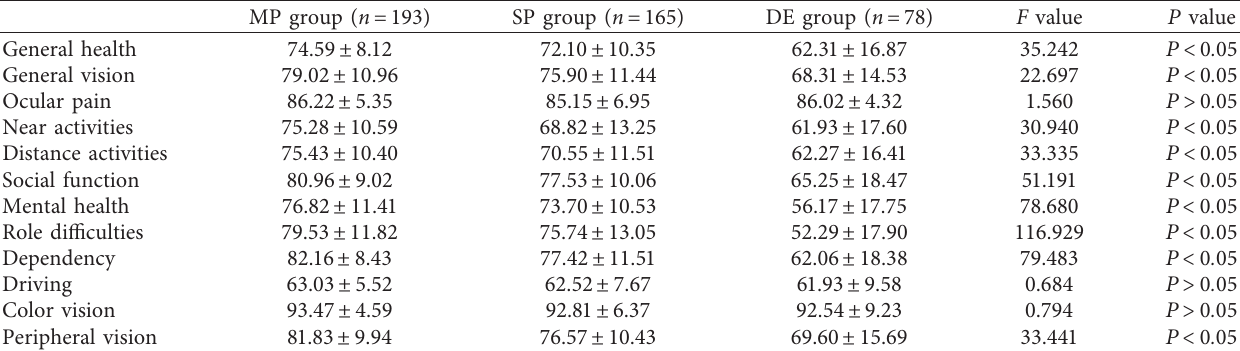
Table 8: Score comparison of the NEI-VFQ-25 in the three groups in two months after treatment.